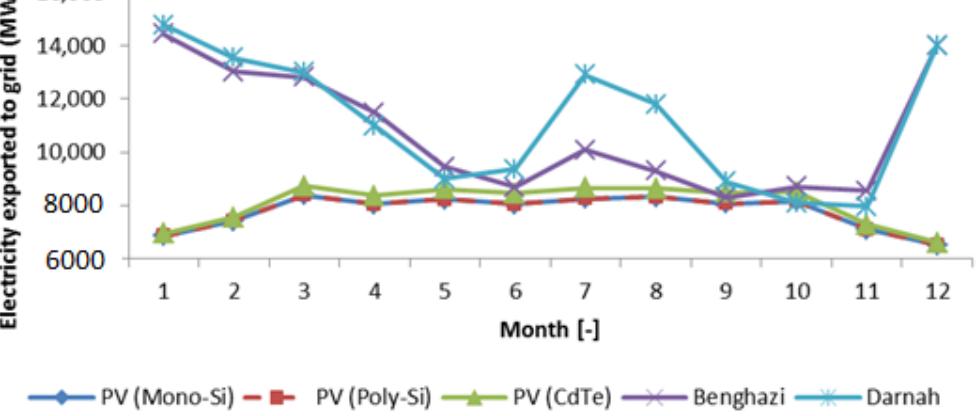
Figure 9. Monthly power exported to the grid for wind and solar projects in the selected regions. Table 12. Financial parameters performance of 50Mri grid-connected wind and solar projects.